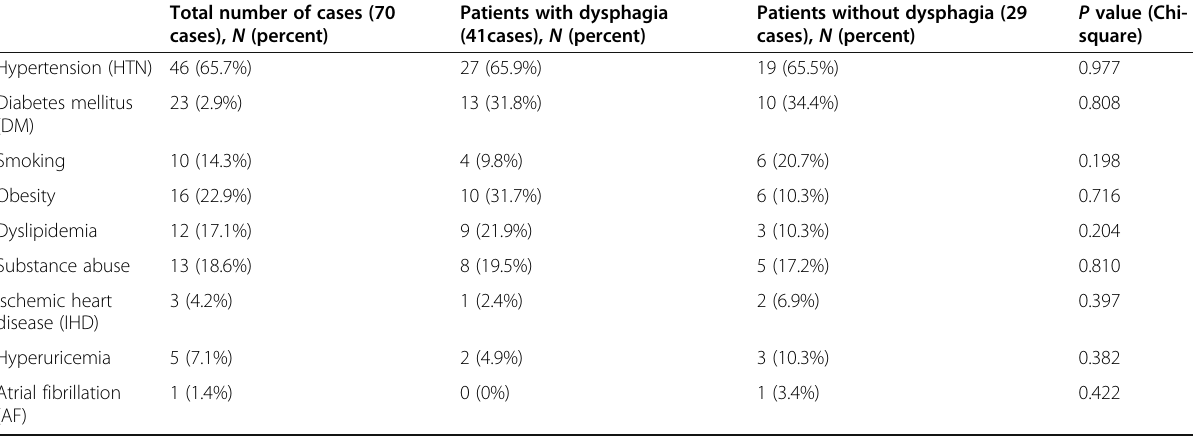
Table 5 Risk factor of hemorrhagic stroke patients according to presence or absence of dysphagia Total number of cases (70 cases), N (percent)